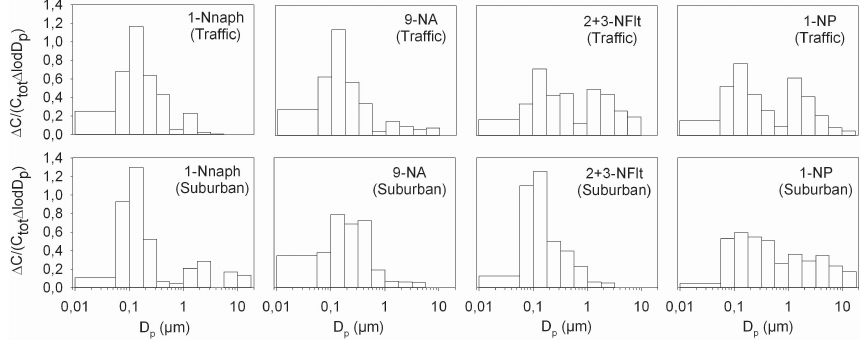
Fig. 4. Particle size distributions of 1-nitronaphthalene (1-Nnaph), 9-nitroanthracene (9-NA), 2+3-nitrofluoranthene (2+3-NFlt) and 1- nitropyrene (1-NP) at traffic and suburban sites.